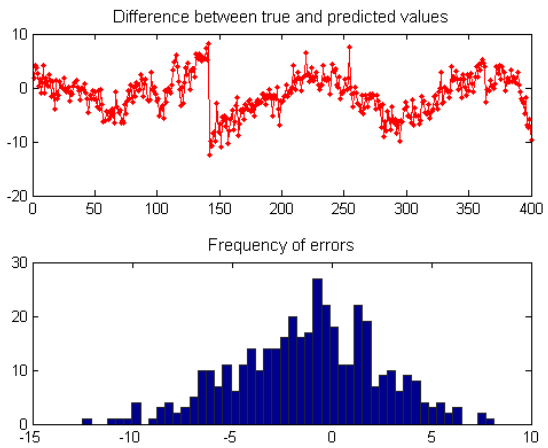
Figure 6. Prediction error of pitch motor temperature test set.